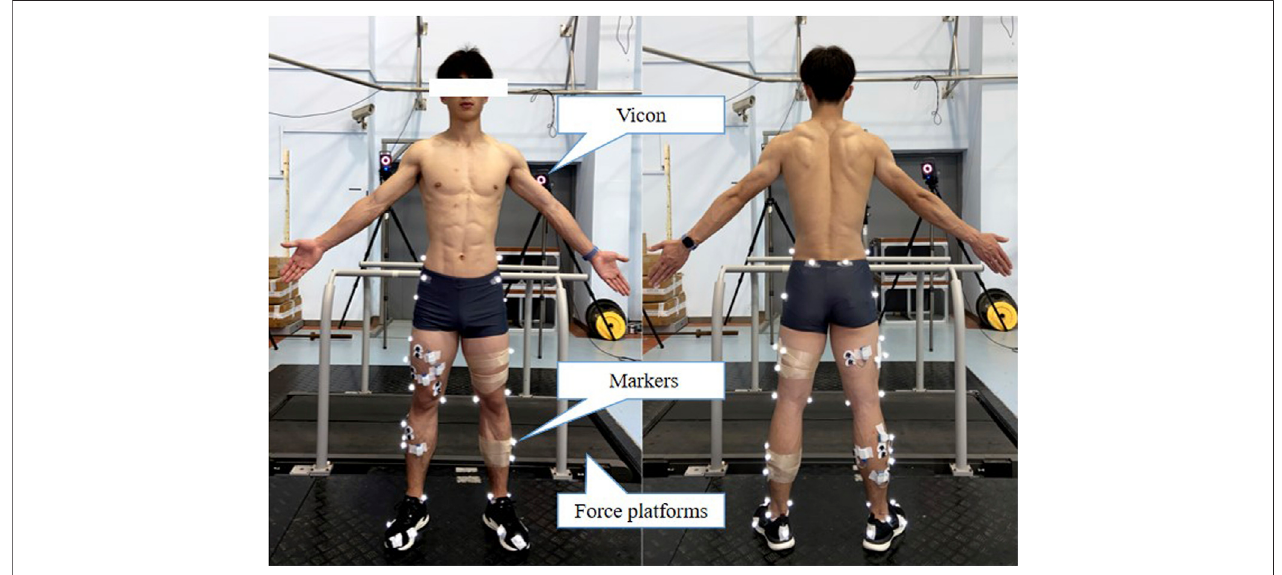
FIGURE 2 | Placement of re fl ective markers and experimental site. The re fl ective markers are placed at the anterior superior iliac spine, superior margin of the iliac crest,posterior superior iliacspine, medial and lateralfemoralcondyles,medial and lateralmalleolus, fi rst and fi fthmetatarsalheads, toeand heeltoidentifythehip,knee and ankle joints. The markers on the T stand are used to track the trajectory of the thigh and shank.